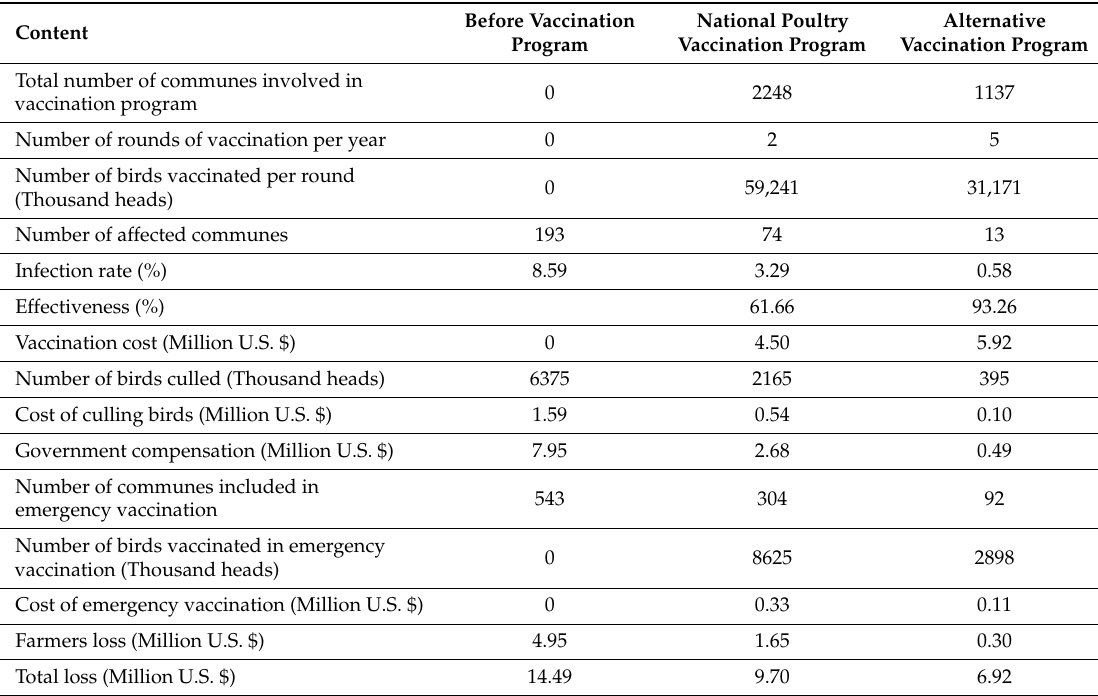
Table 4. Cost-effectiveness analysis of the two